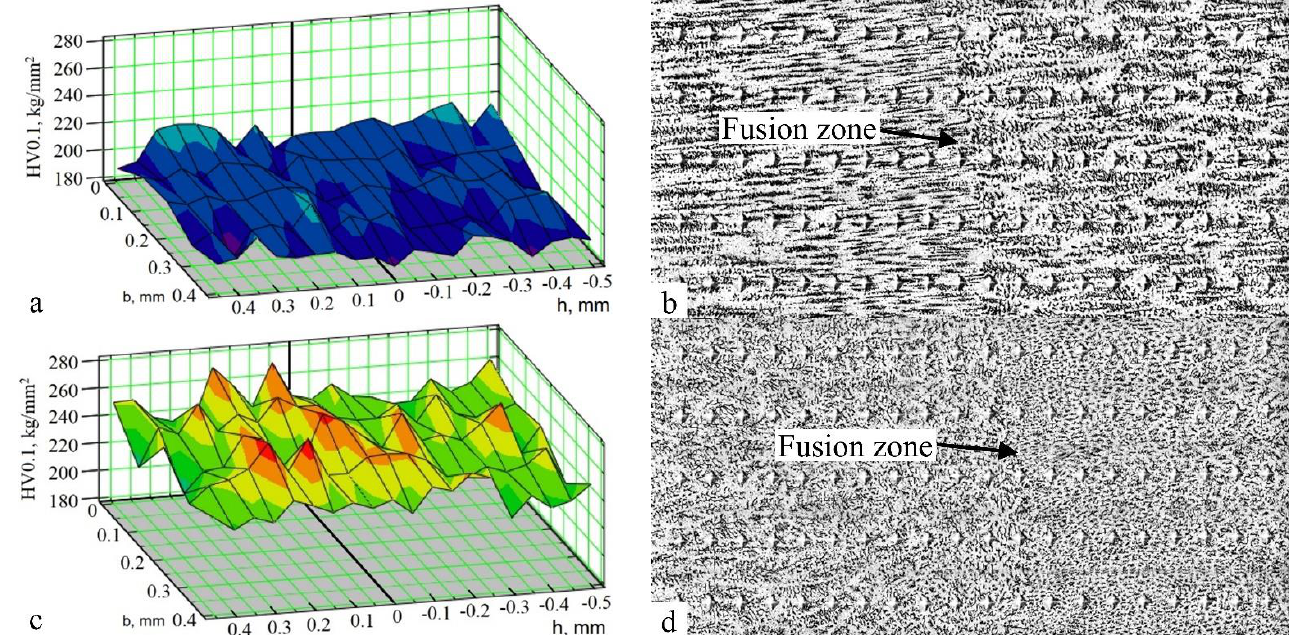
Figure 13. Microhardness maps for the transition zone between layers ( a , c ) and measurement examples ( b , d ): ( a,b )—welding deposition without peening; ( c,d )—welding deposition with layer- by-layer peening; h–measurements in layer depth, ( b )—measurements in layer width.